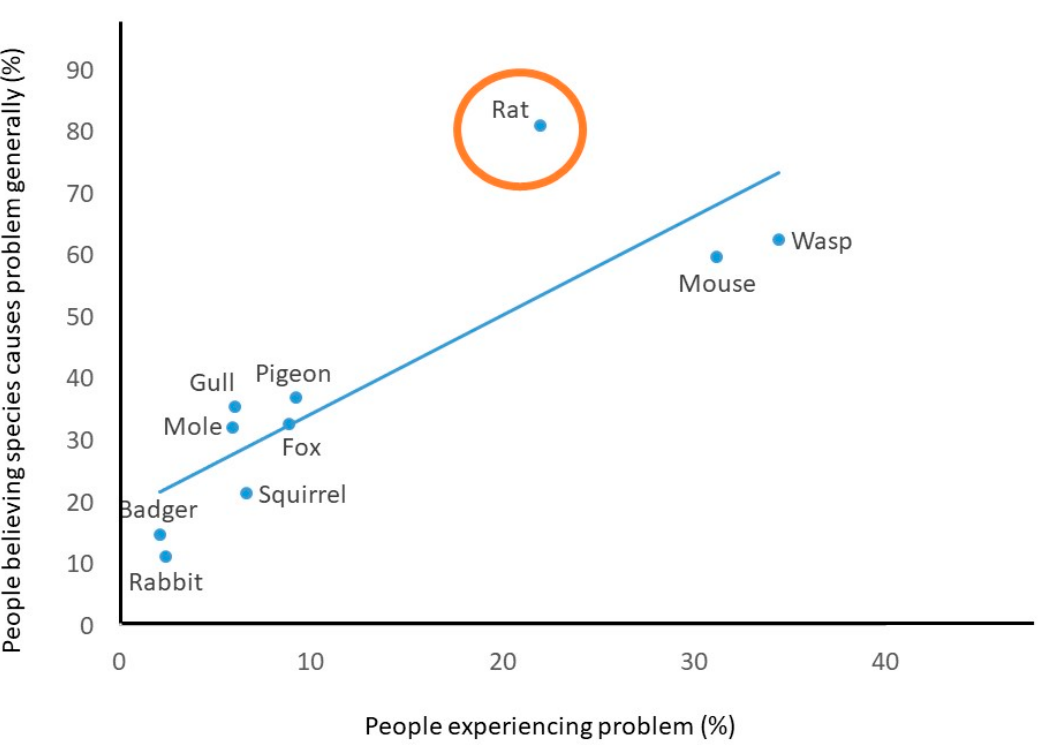
Figure 2. Relationship between whether people had experienced a problem with a species (percentage of people reporting) and whether they believed it to cause a problem generally in the UK (percentage of people believing) ( n = 2000).